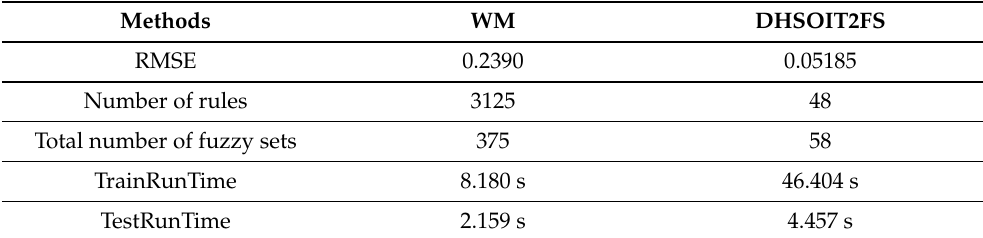
Table 2. Comparison of the results of the two methods in